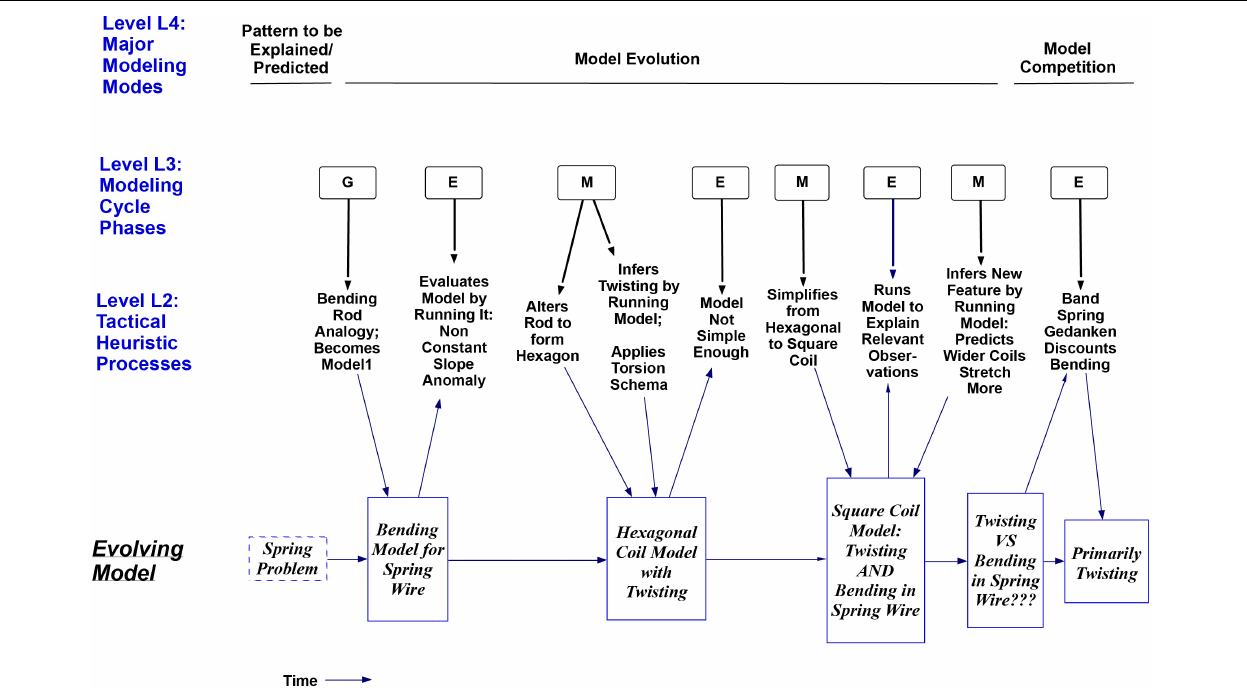
FIGURE 4 | Time sequence diagram for three levels of model construction processes used by S2, and the resulting sequence of models. The row labeled Level 3 uses the letters G, E and M to show the Generation, Evaluation, or Modification phase of the GEM Cycle described earlier in Figure 1 . The cycle is seen here as generating an alternating pattern of Evaluations and Modifications. The row labeled Level 2 shows the Tactical Heuristic Processes that helped to evolve the model in each of the above phases. These are seen as subprocesses for each phase at Level 3, as indicated by the thick black downward arrows, which mean ‘Utilizes the Subprocess’. The bottom row in the figure does not show reasoning processes or a process level, but rather the progression of new models resulting from the processes above it, as indicated by the thin blue downward arrows from Level 2 to the models underneath. The top row shows major Model Construction Modes to be discussed later, including a Model Competition Mode for deciding whether bending or twisting is the dominant model for deformation in the spring. been used in many ways. Here I use downward arrows